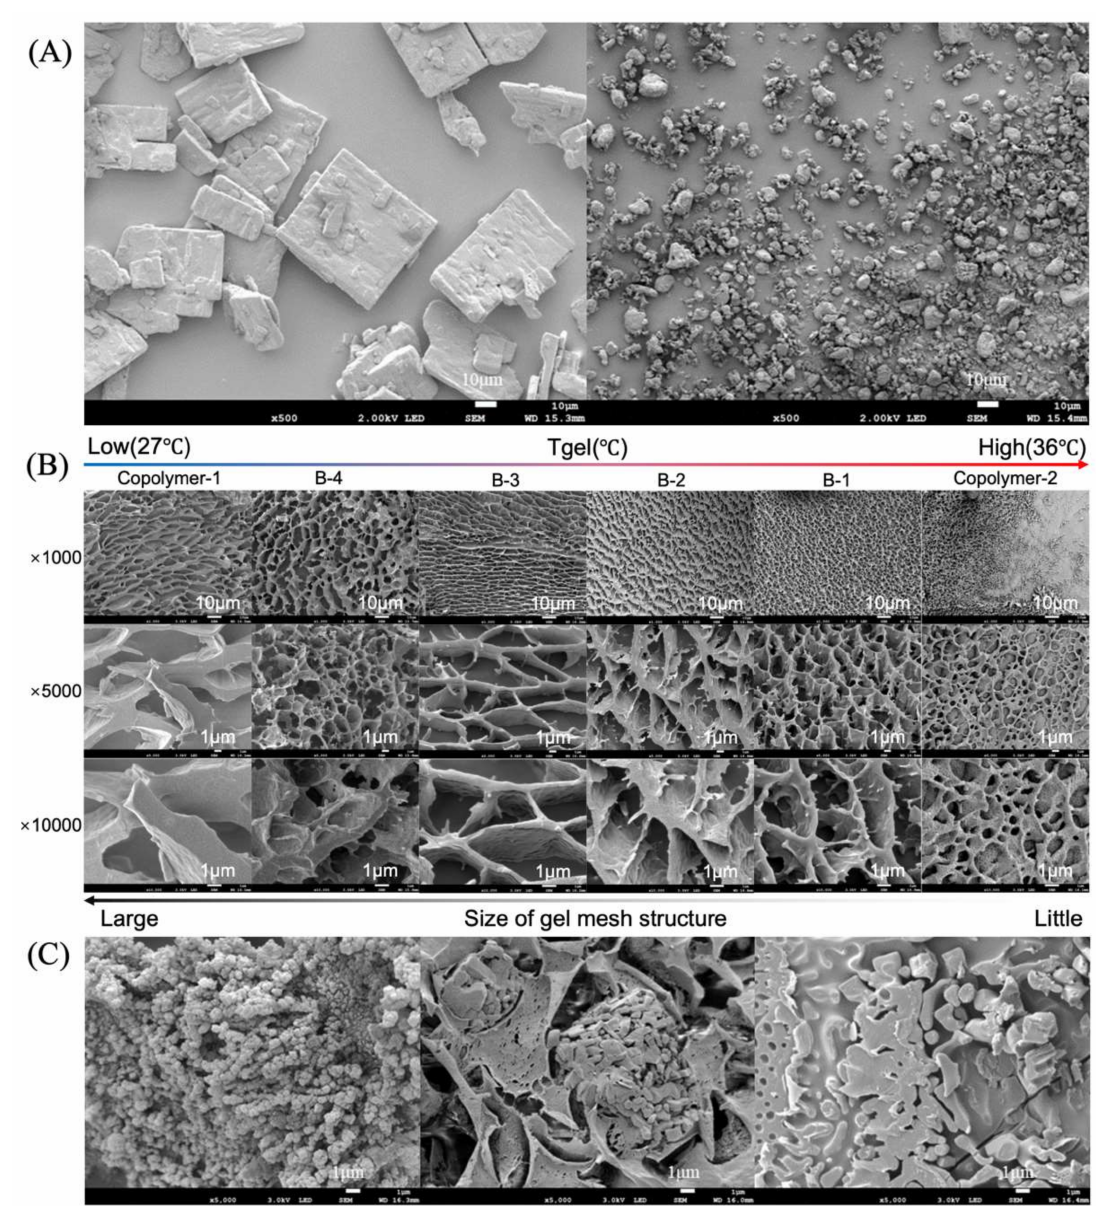
Figure 3. Photographs of SEM and cryo-SEM. ( A ) SEM examination of TMZ crystal micromorphology and micro-TMZ micromorphology. ( B ) Cryo-SEM analysis of 20 wt% PLGA–PEG–PLGA blend samples demonstrates the creation of a distinctive hydrogel mesh structure at 37 ◦ C. ( C ) Three micro- TMZ distribution topologies were identified in the thermosensitive PLGA–PEG–PLGA hydrogel mesh